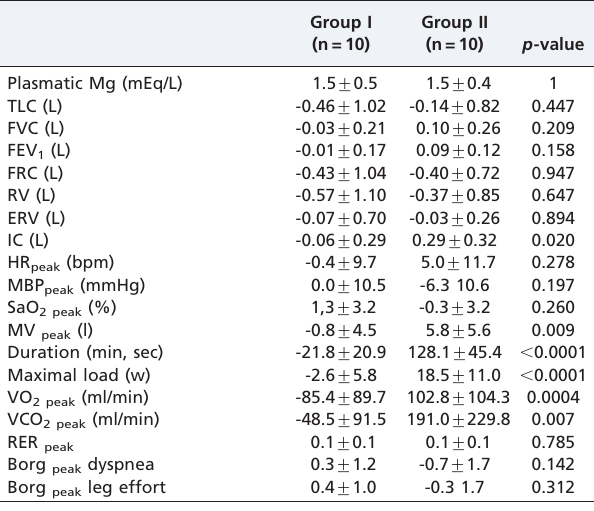
the maximal achieved load associated with Mg treatment. This occurred although there were no significant differences in the peak oxygen consumption, or in Borg dyspnea and the leg fatigue scores, between treatment days. These results indicate that the overall exercise performance improved after Mg loading, as more work was performed with the Table 5 - Comparisons between Mg treatment effects with COPD patients classified according to the level of work load response *. Group I Group II (n=10) (n=10) p- value Plasmatic Mg